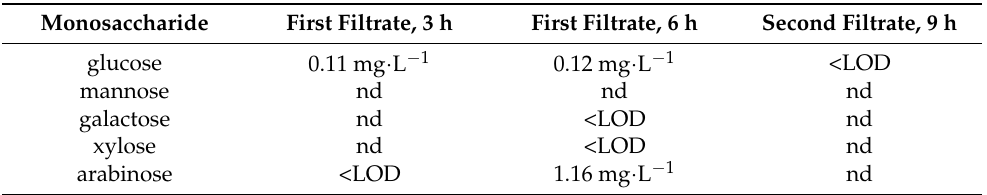
Table 3. Monosaccharide content in the first filtrates after 3 or 6 h of delignification and second filtrates after additional 3 h of delignification (9 h altogether).